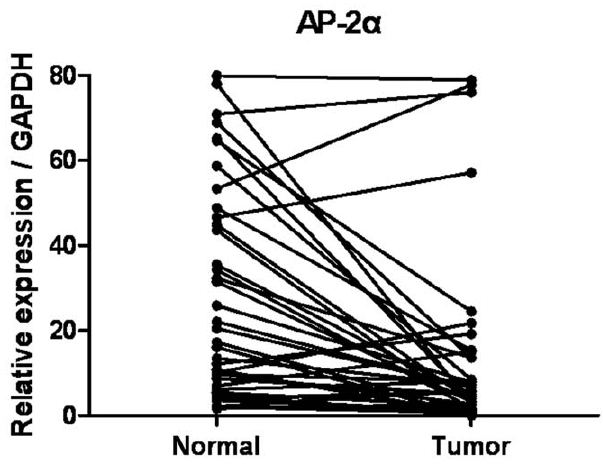
Figure 1. RT-qPCR analysis of AP-2 a expression in gastric cancer patients. Relative expression of AP-2 a in gastric cancer tumor tissues compared to adjacent non-tumor tissues (n=41) assessed by RT- qPCR (P=0.009).